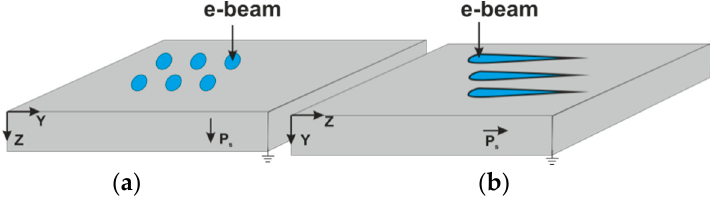
Figure 1. The scheme of electron-beam (EB) domain writing on the polar ( a ) and nonpolar ( b ) surfaces of a ferroelectric crystal.